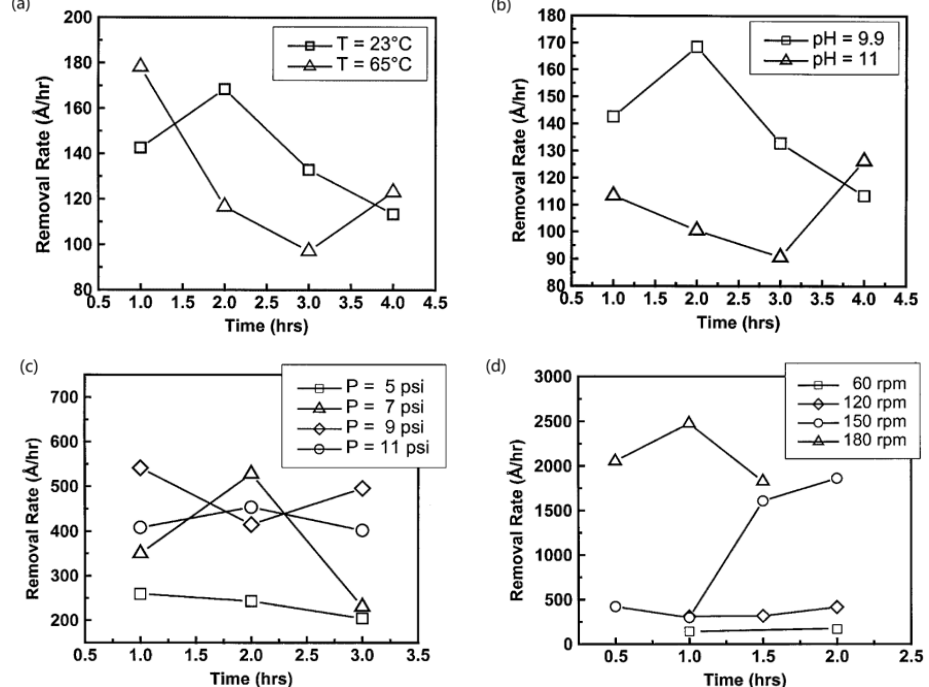
Figure 4. The effects of ( a ) temperature, ( b ) slurry pH, ( c ) applied pressure, and ( d ) polishing rota- tion rate on the MRR of 4H-SiC [24].